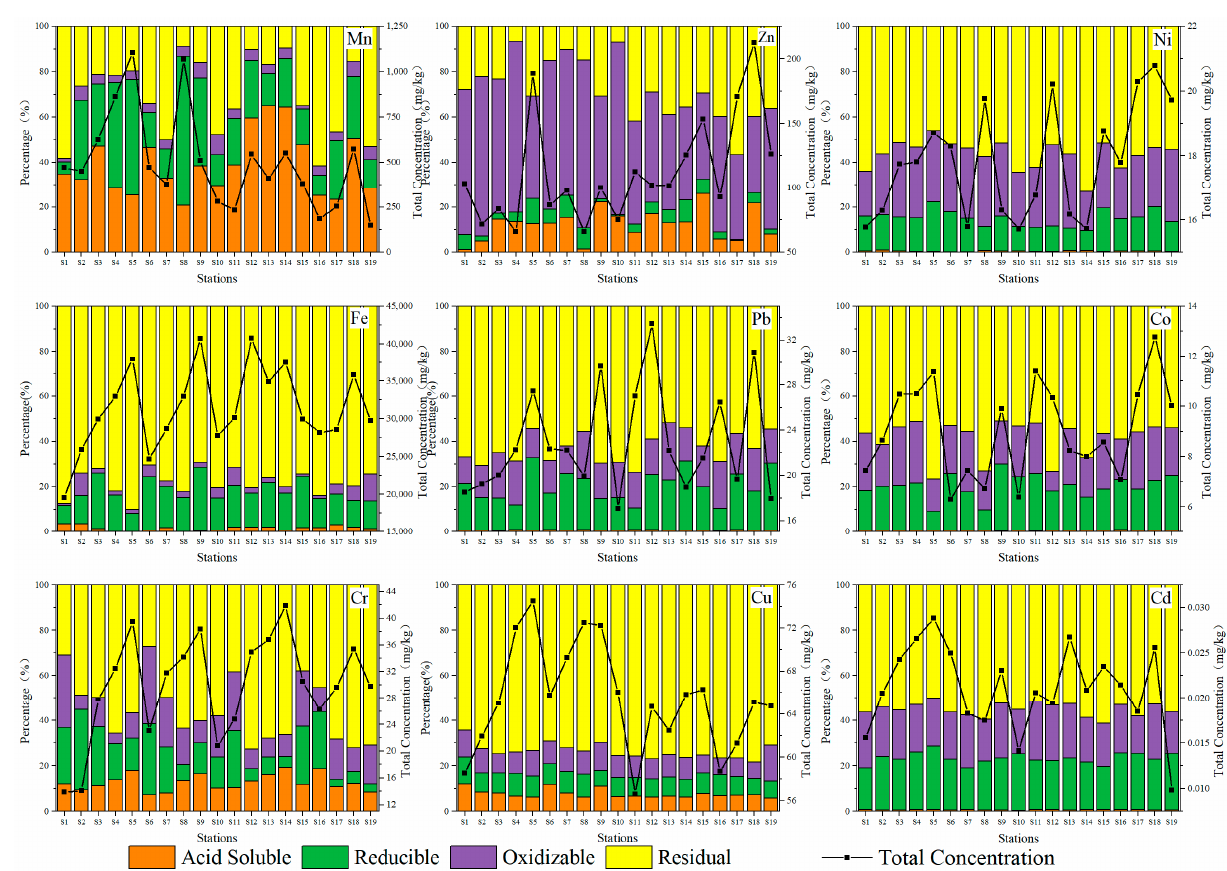
Figure 3. Percentage distribution of heavy metals in four geochemical fractions at 19 stations.